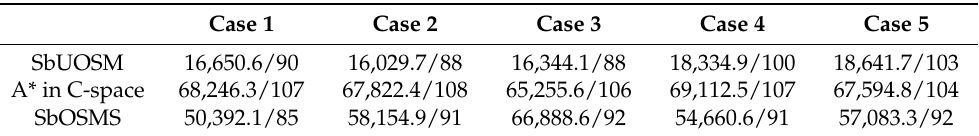
Table 4. Summary table of algorithm execution times/total planning steps for the three algorithms under the six cases (Unit: μs /steps)